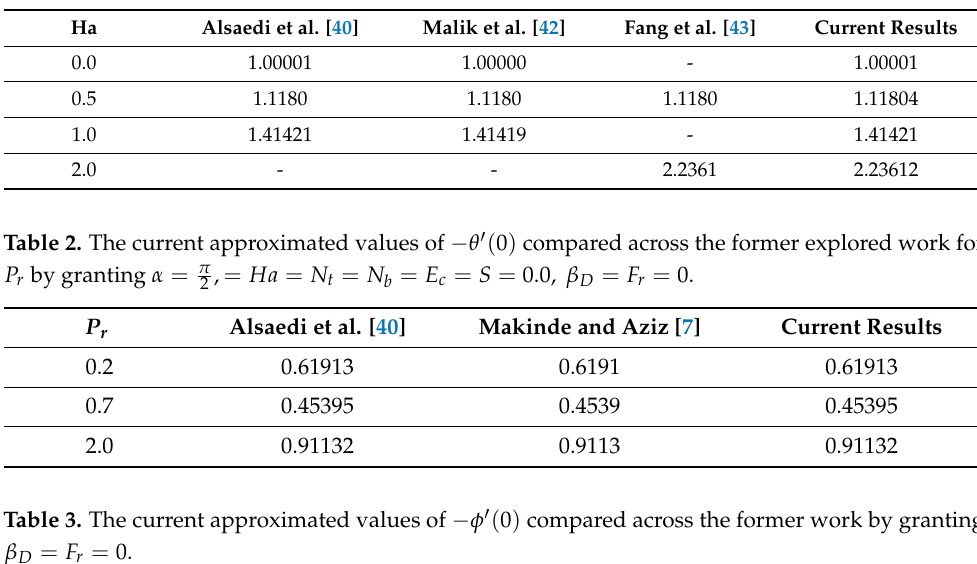
Table 1. The current approximated outcomes of the skin-friction coefficient across Ha by granting